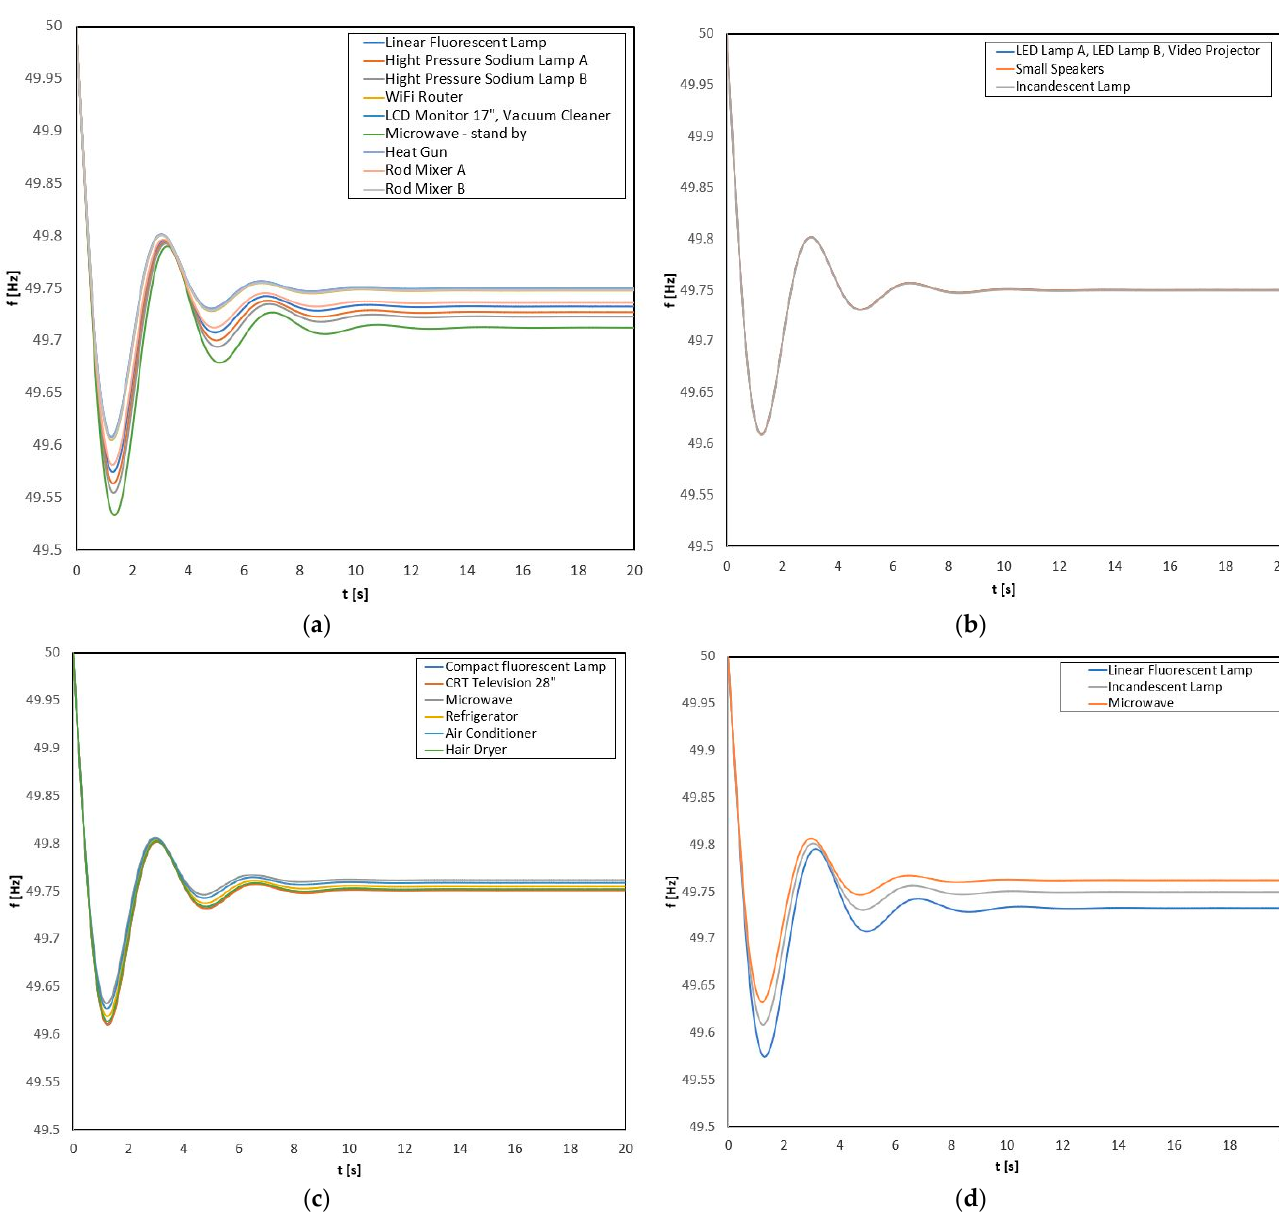
Figure 11. Frequency response after production outage of 10% considering chosen appliances as loads only with ( a ) negative effect; ( b ) no effect; ( c ) positive effect; ( d ) comparatively different effects. Table 9. Simulation results after production outage of 10% considering chosen appliances as only load.